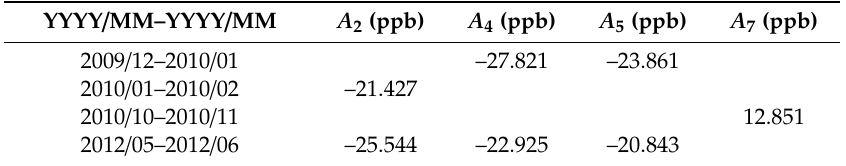
Table 5. Atmospheric CH 4 changes in the trend components over A 2 , A 4 , A 5 , and A 7 at each breakpoint. At a breakpoint, an increase is positive, but a decrease negative.